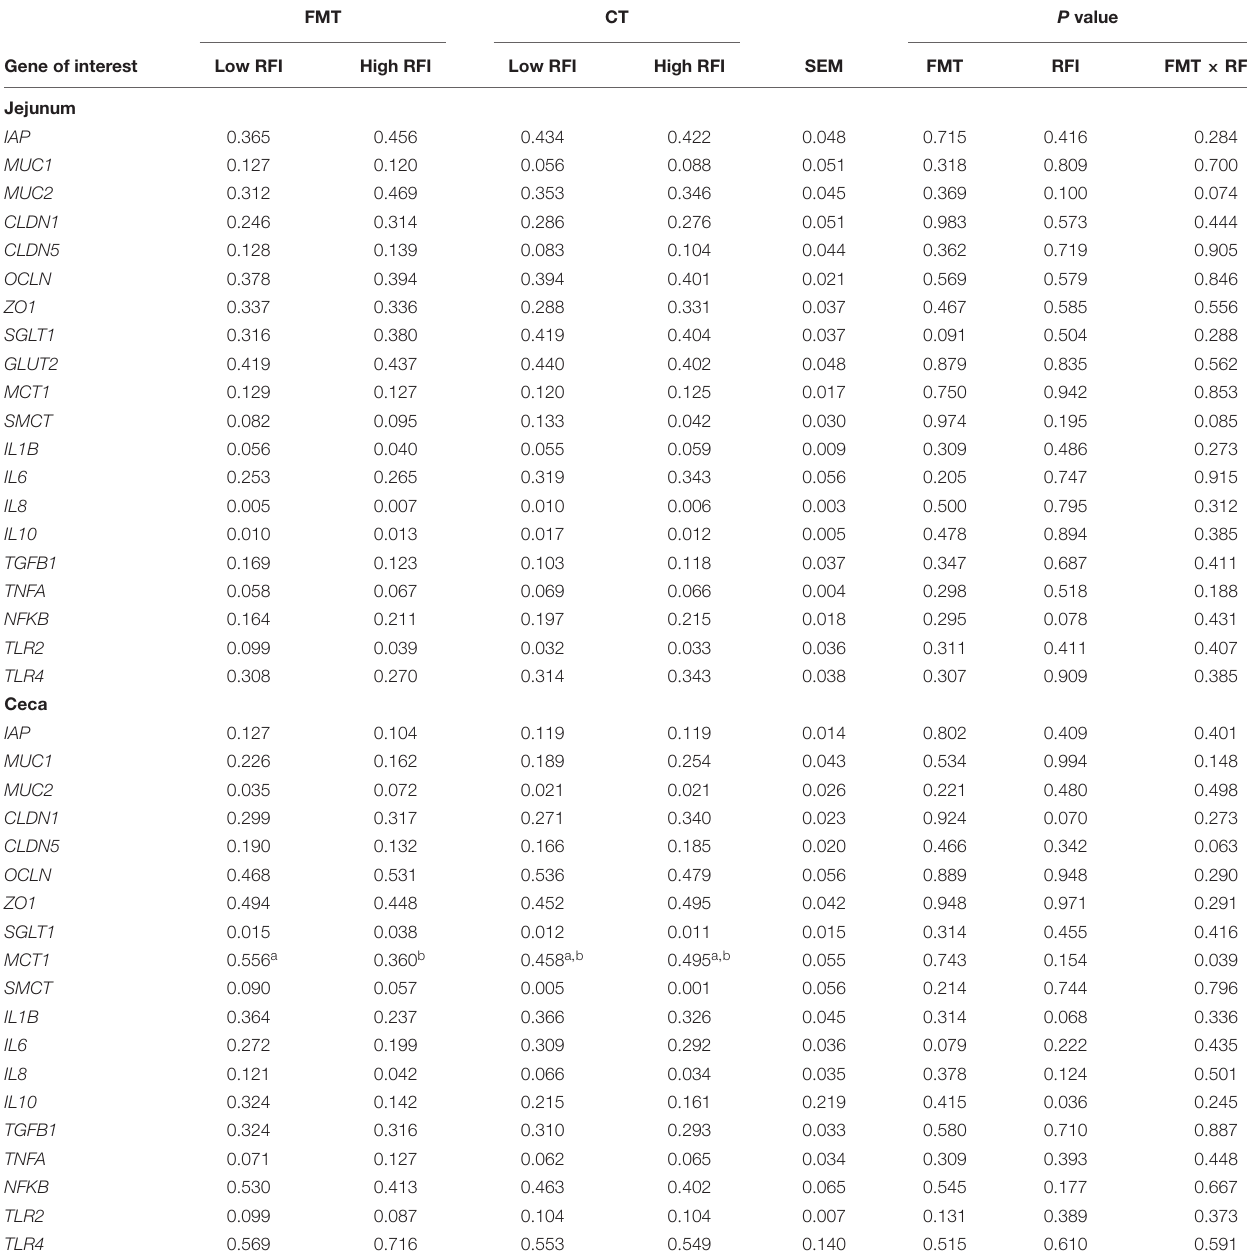
TABLE 4 | Differences in expression levels of nutrient transporter, barrier, and innate immune genes at the jejunal and cecal mucosa of low and high residual feed intake (RFI) broiler chickens receiving either a fecal microbiota transplant (FMT) or a control transplant (CT). FMT CT P